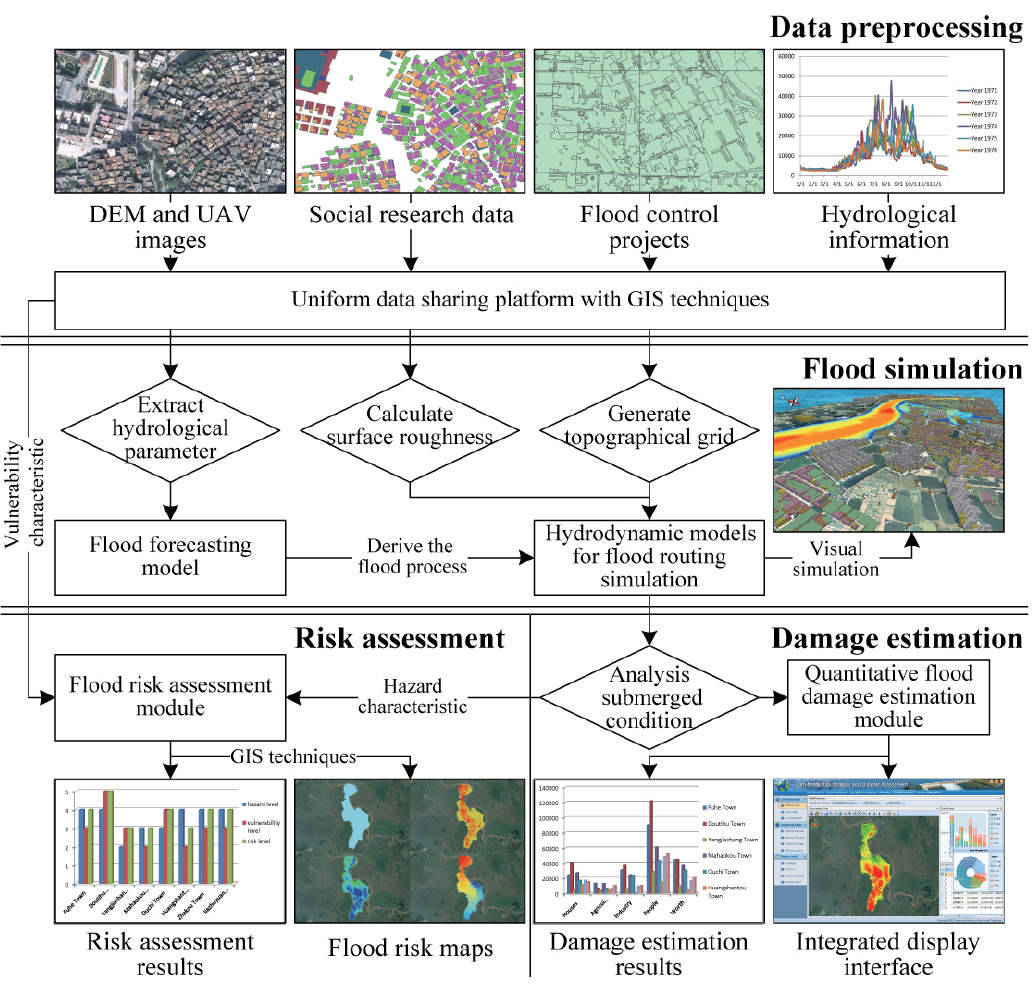
Fig. 7. A feasible decision process for flood risk assessment and damage estimation.